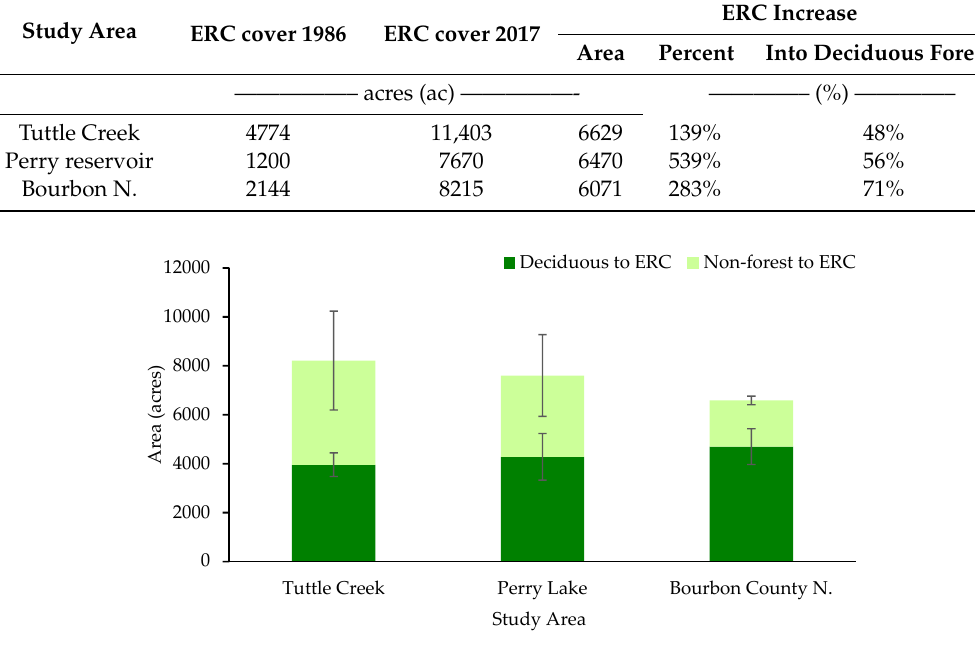
Figure 8. Total eastern redcedar (ERC) encroachment between 1986 to 2017 in the three study areas, broken down by conversion of deciduous forests and non ‐ forest classes to ERC. Table 6. Thirty ‐ year ERC change within the three study areas.